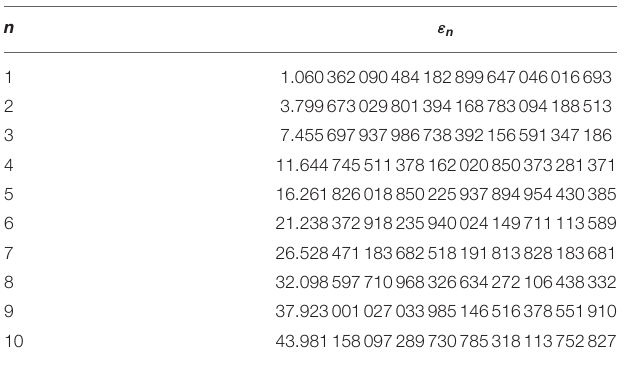
TABLE 2 | The 10 lowest eigenvalues of the quantum anharmonic oscillator, calculated to high precision by the method described in [14], from the Schrödinger